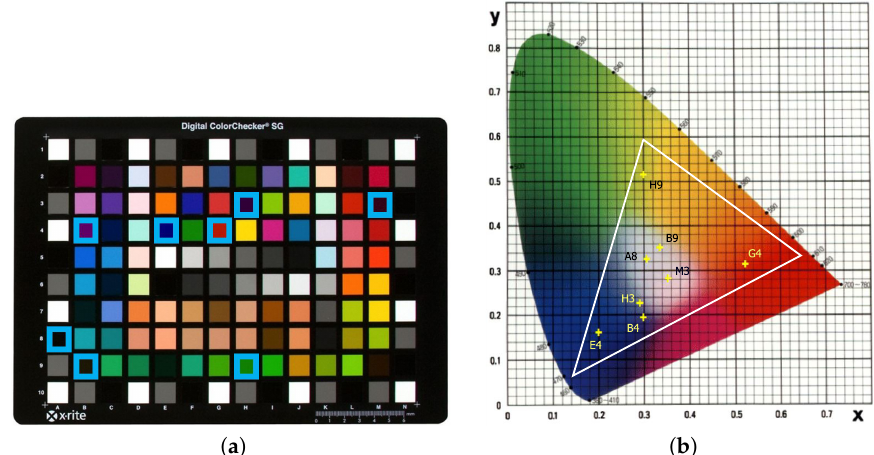
Figure 6. Patches with higher LOOCV ∆ E ∗ chromaticity